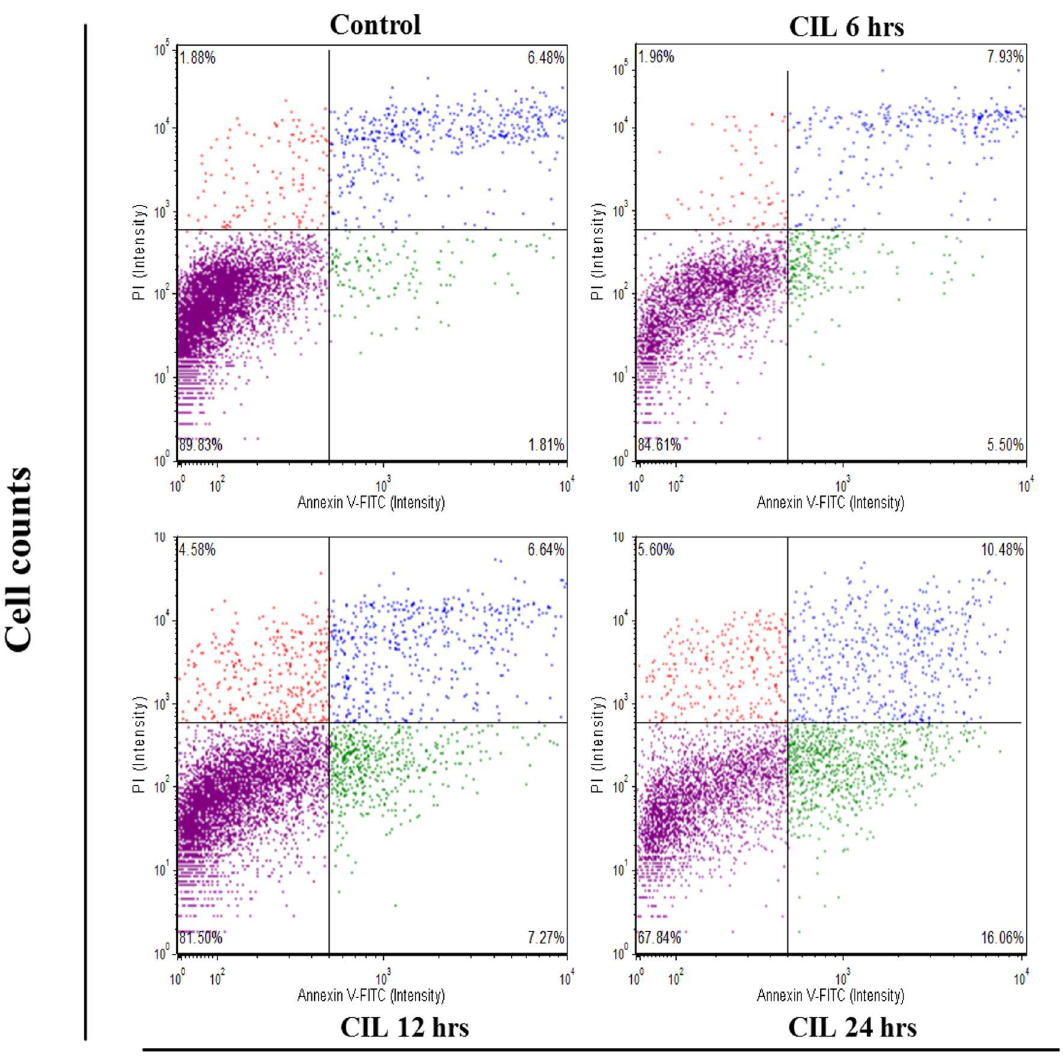
Fig 2. After an indicated treatment for 24 h, the DLD-1 cells were stained with FITC-conjugated Annexin-V and PI for flow cytometry analysis as described in Materials and methods. The percentagespresentedin each frame depictedthe apoptotic cells. * P < 0.01, comparedwith the control group (0.2%